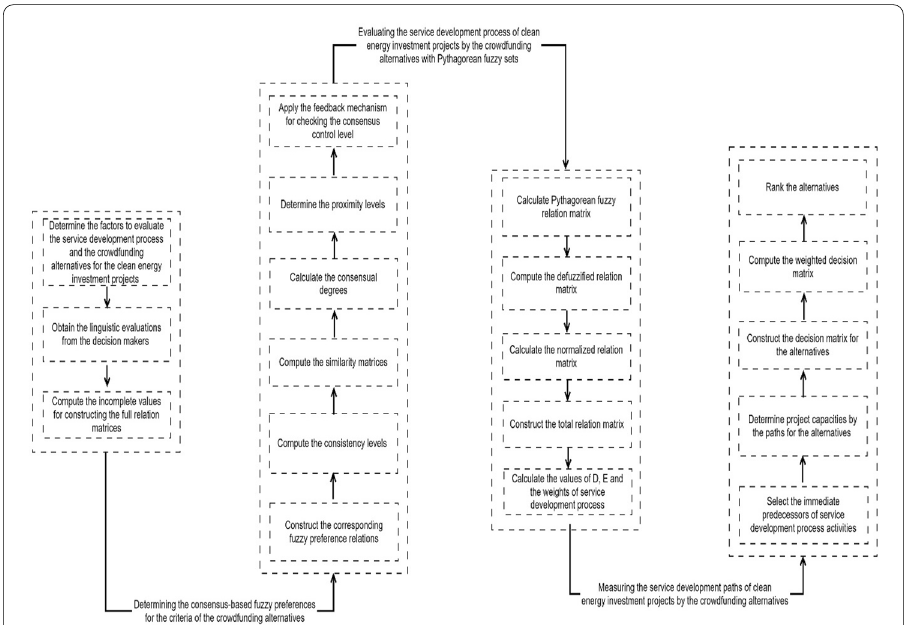
Fig. 2 Algorithm of the hybrid decision support